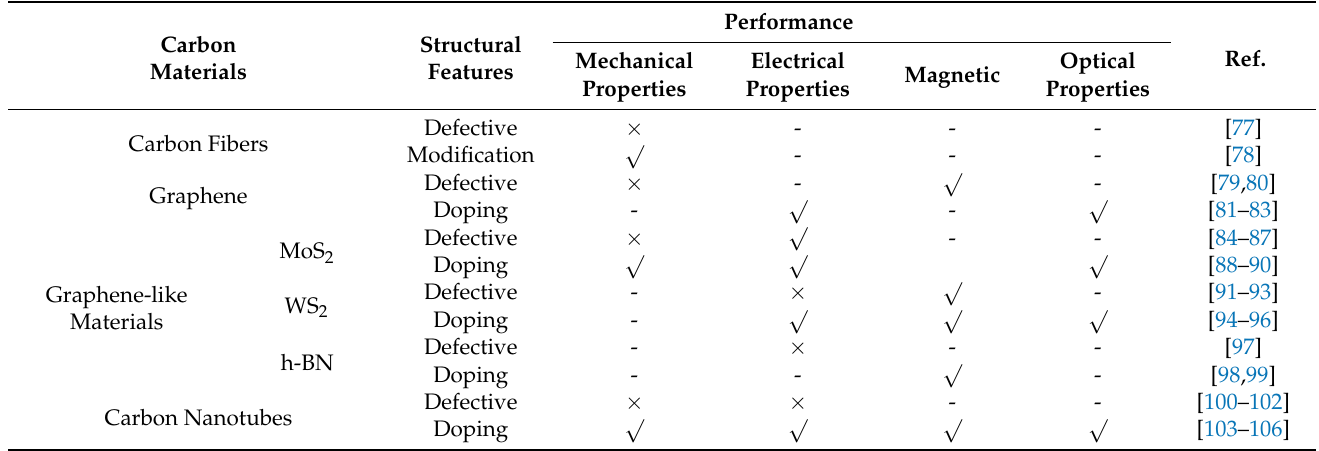
Table 1. Structure and